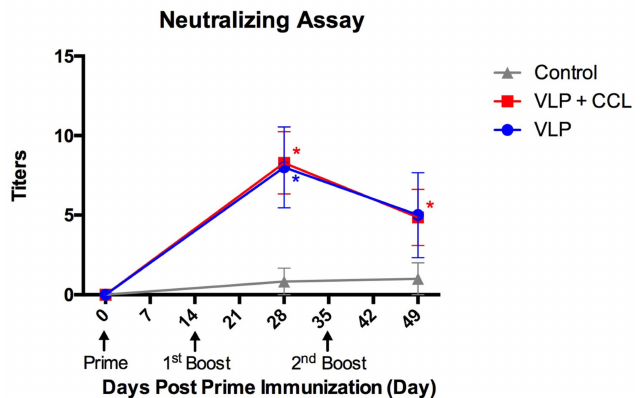
Figure 9. The titers of plasma neutralizing antibodies against PEDV following the prime, 1st boost, and 2nd boost immunization. The neutralizing activity against PEDVPT-P5 was performed. The values are displayed as mean ± SEM and presented as gray, blue, and red lines of control, VLP, and VLP + CCL groups, respectively. The asterisk indicates the significant statistical di ff erence between treatment and control groups ( p <